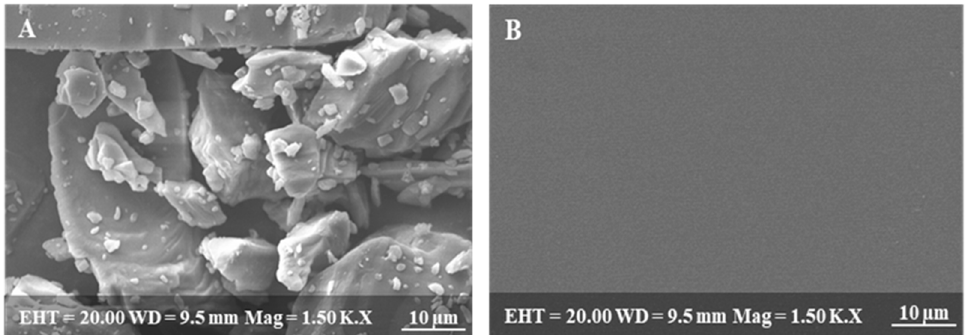
Figure 1. Scanning electron microscopic images of ( A ) pure drug, ( B ) RZT-ODFs.